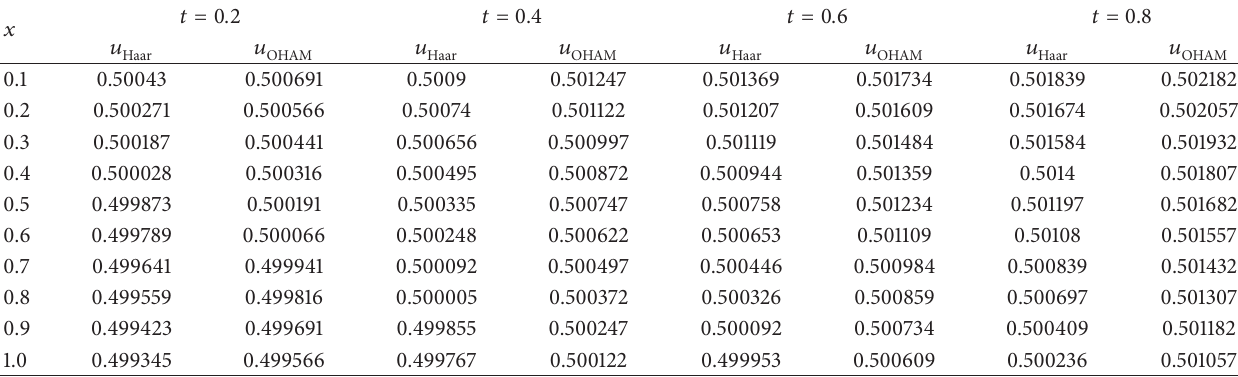
Table 3: The approximate solutions of fractional order Burgers-Fisher equation (35) using Haar wavelet method and three terms for second- order OHAM with convergence control parameters 𝐶 1 = −0.000104528 and 𝐶 2 = −0.99979 at various points of 𝑥 and 𝑡 for 𝛼 = 0.75 .